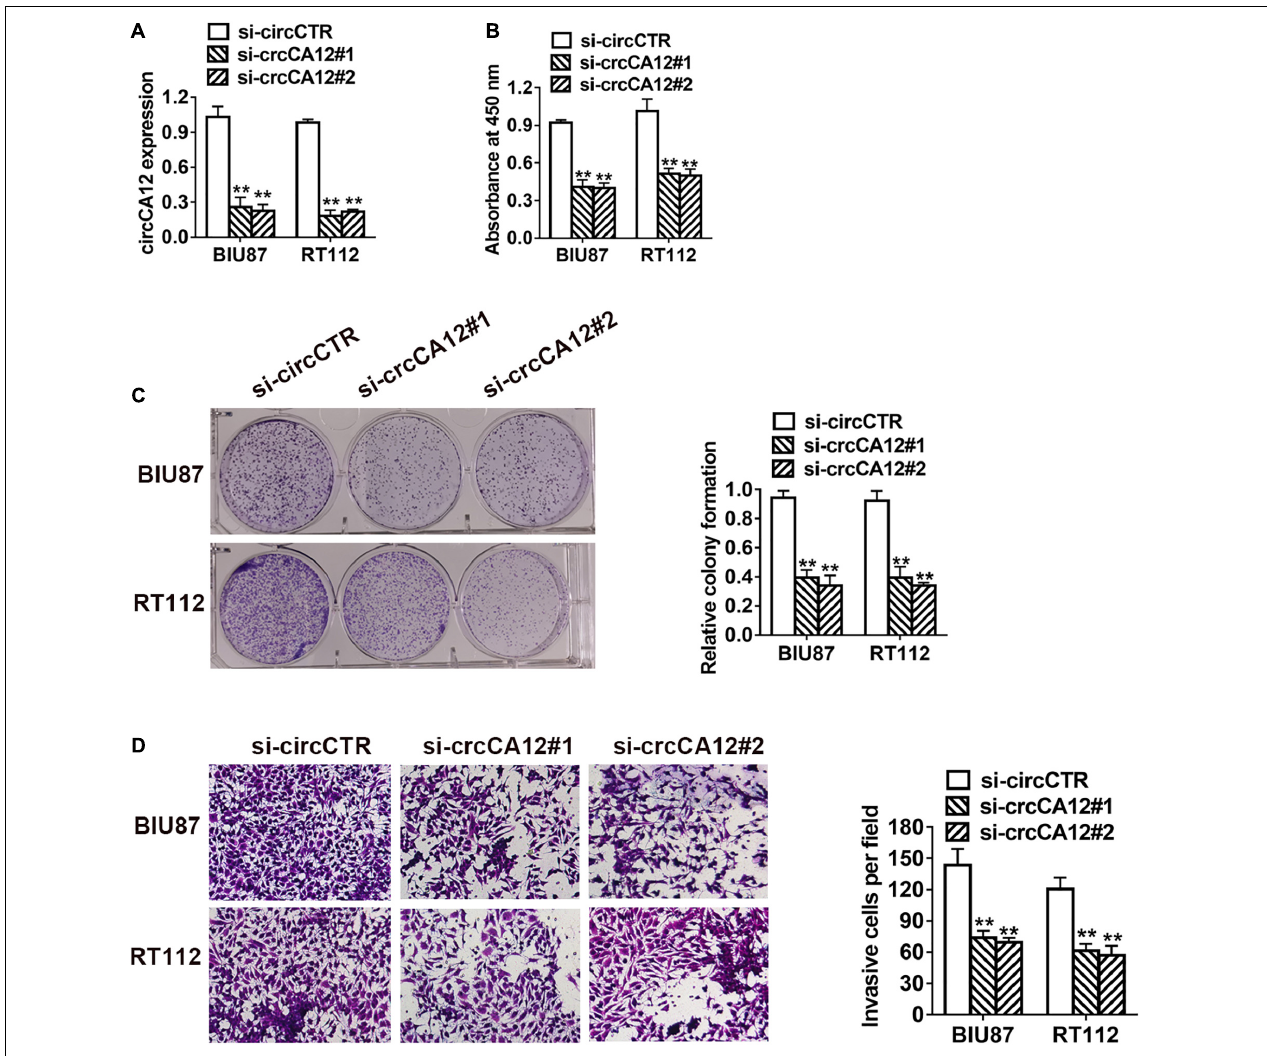
FIGURE 2 | CircCA12 promotes cellular growth along with metastasis in bladder cancer. (A) The knockdown of circCA12 determined using qRT-PCR. (B) CCK-8 assay of cell proliferation. (C) Colony formation assays. (D) Suppression of circKIF4A decreased the infiltration potential in the Transwell assay. ** P <